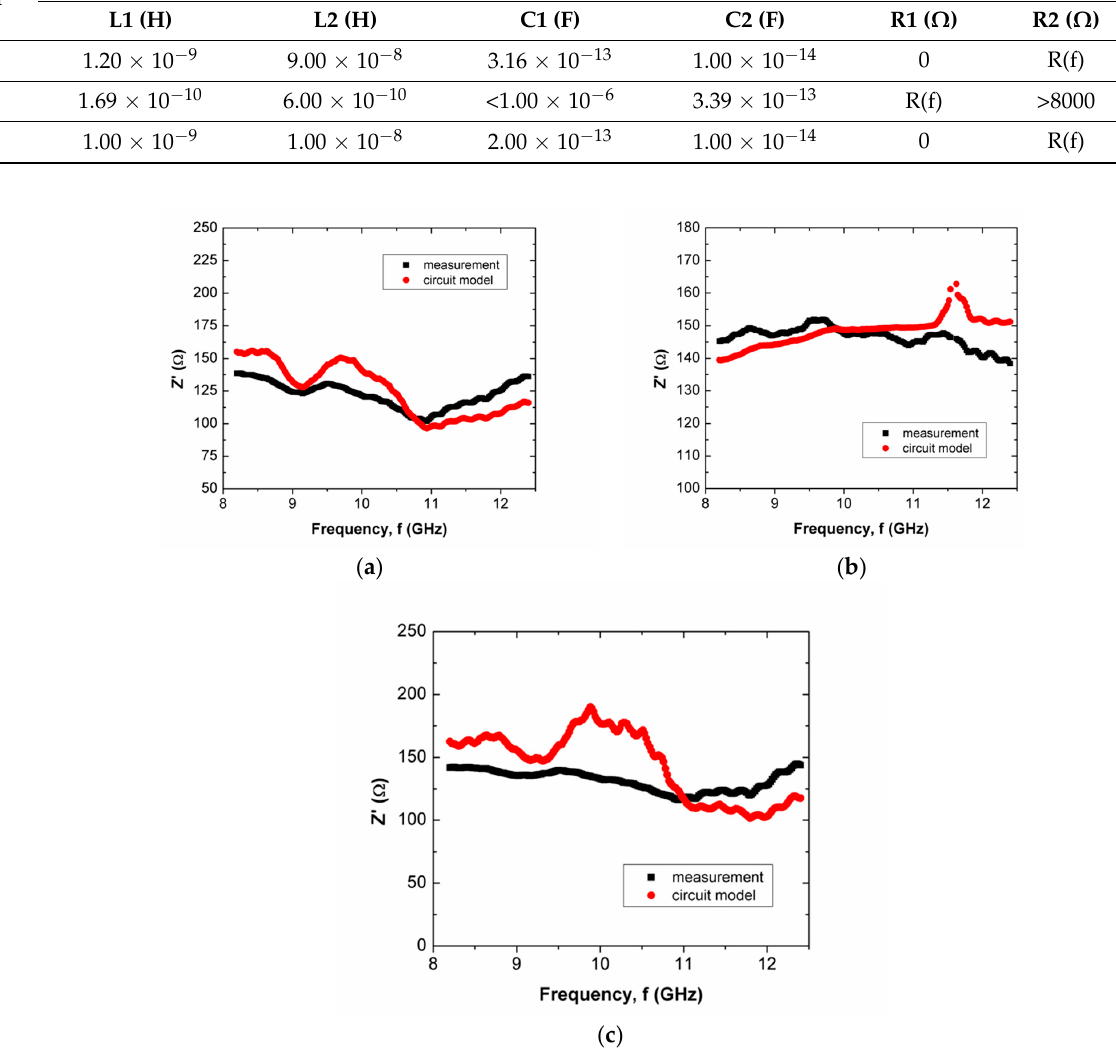
Figure 5. Comparison between measured and simulated Z’ (real part of impedance) of scaffold composites with ( a ) 50% Wangi rice starch and 50% nHA, ( b ) 60% Wangi rice starch and 40% nHA and ( c ) 70% Wangi rice starch and 30% nHA, at X-band.